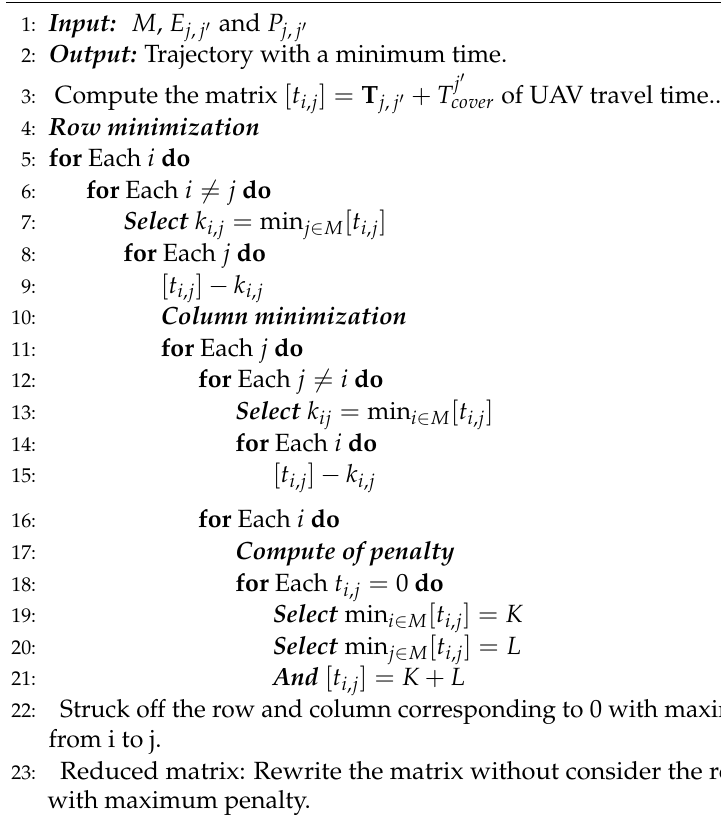
Algorithm 1 Shortest Traveling Time Trajectory (STTT)